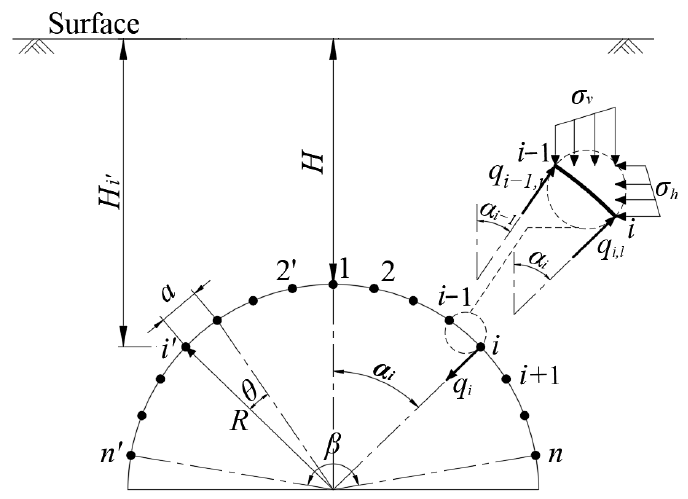
Figure 2. Schematic diagram of a cross section of the pipe roof pre-support.